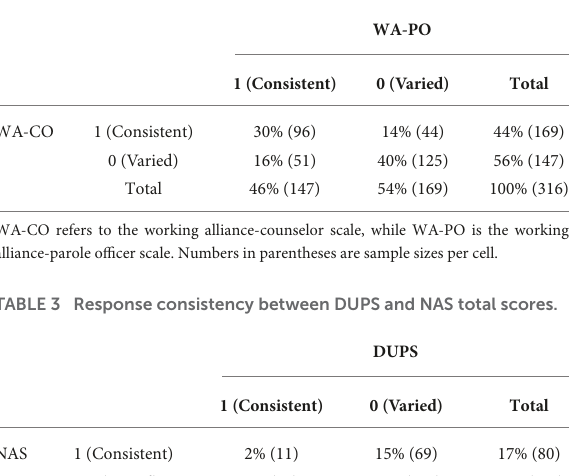
TABLE 2 Response consistency between WA-CO and WA-PO total scores.